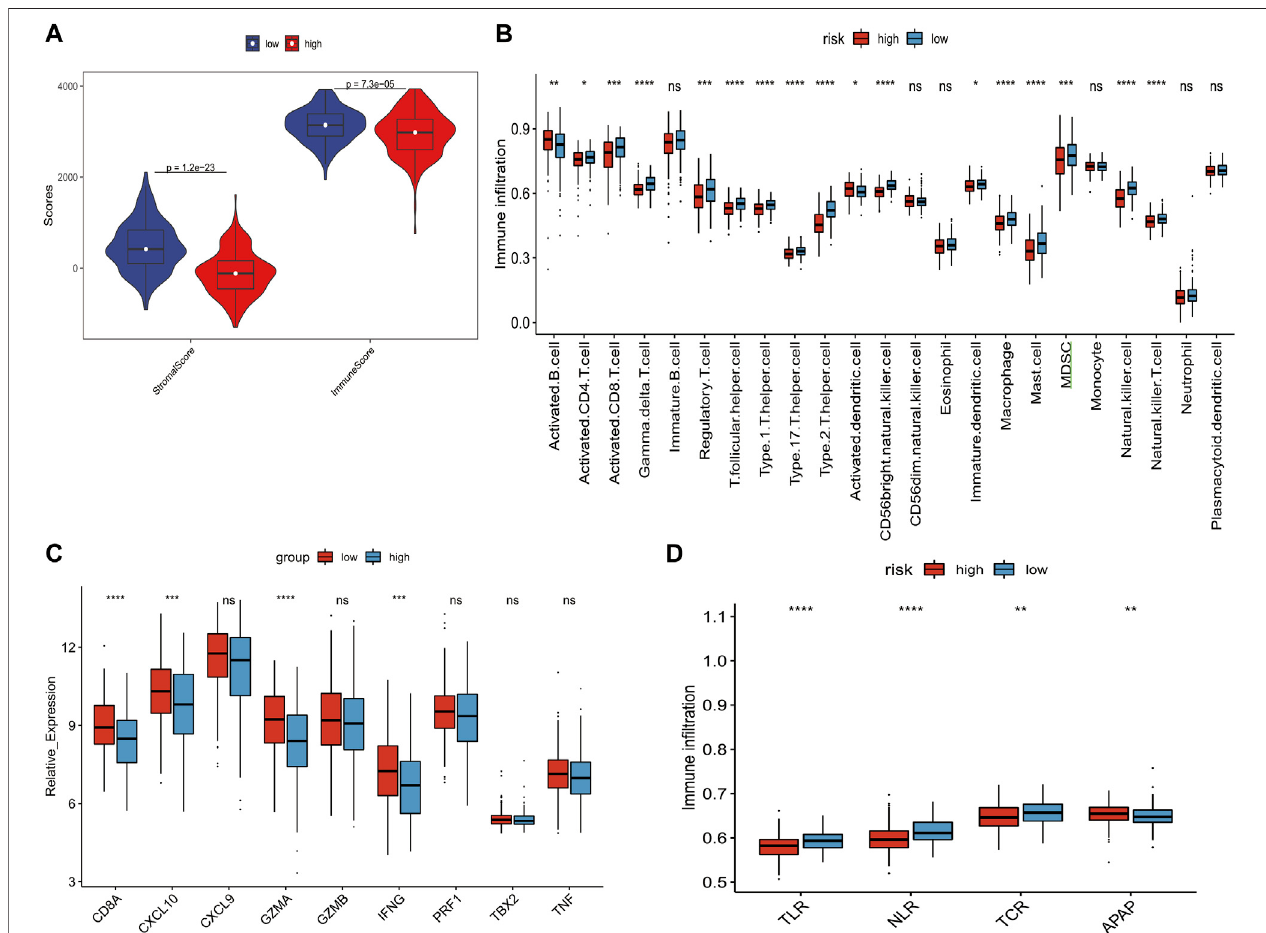
FIGURE 10 | Correlation between gene signature and the tumor microenvironment and immune reaction. (A) Differences of immunescore and stromalscore (calculated by the ESTIMATE algorithm) between high-risk and low-risk patients. (B) Abundance of each TME cell in high-risk and low-risk groups. (C) Difference in the immune-activation – related gene expression between high-risk and low-risk patients. (D) Differences in immune-activated pathways between high-risk and low-risk patients.TLR,Toll-likereceptor;NLR,NOD-likereceptor;TCR,T-cellreceptor;APAR,antigenprocessingandpresentation.Thestatisticaldifferenceoftwogroups was compared by the Wilcoxon test. * p < 0.05; ** p < 0.01; *** p < 0.001; and **** p <